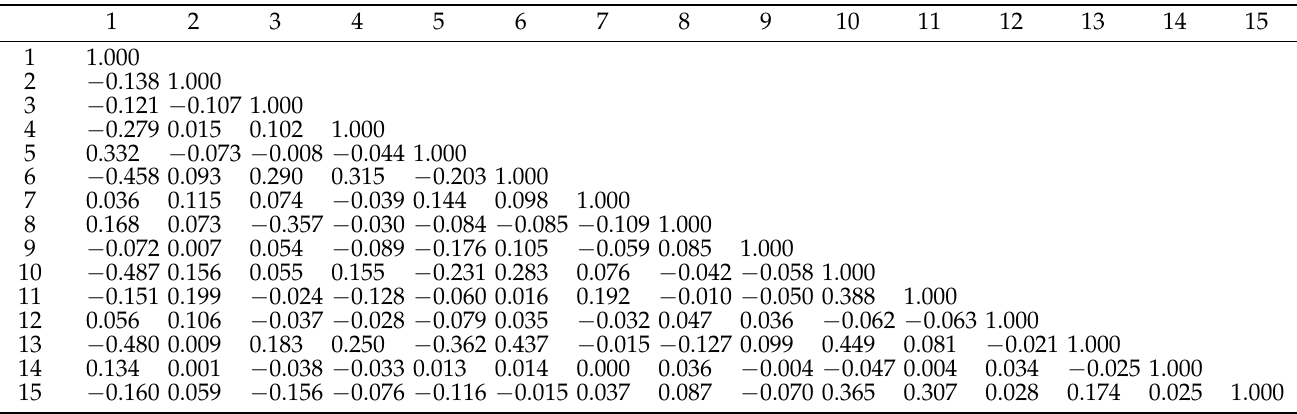
Table 4. Pearson correlation coefficient of retained landslide susceptibility assessment